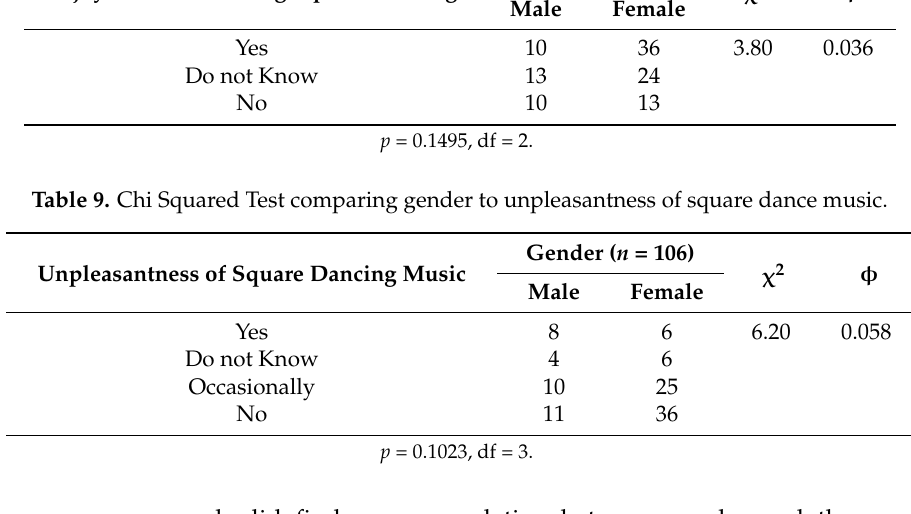
Gender ( n = 106) χ 2 φ Male